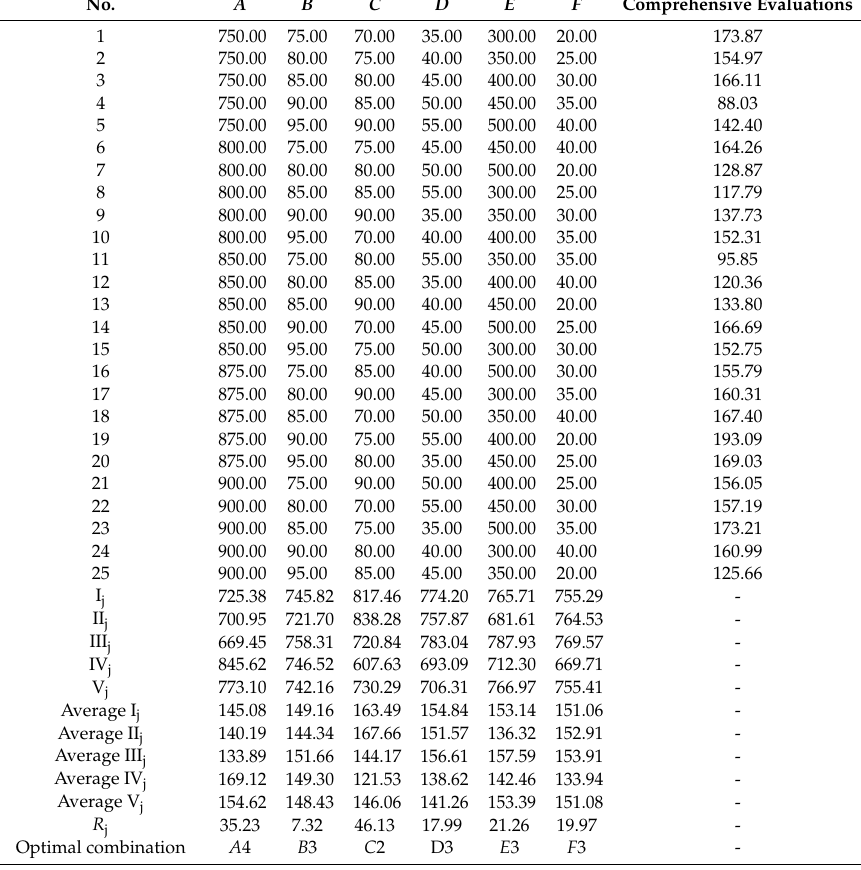
Table 8. Data table of comprehensive score range